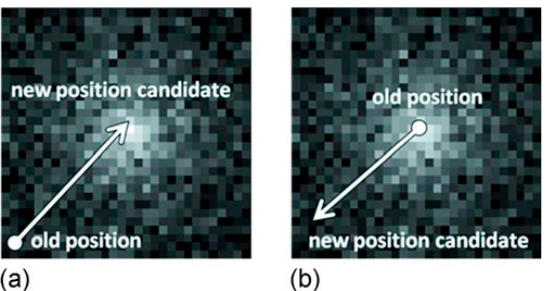
Figure 14. Example of an implication of event position by the SOE method. The event may move to the new location or remain at the current (old) location, according to the acceptance probability equation: ( a ) a new position will be accepted with 100% probability as in this case the event density increases; ( b ) the new position will be accepted with low probability due to the sharp decrease in event density. The figures are rearranged and reprinted with permissions from Andreyev et al.